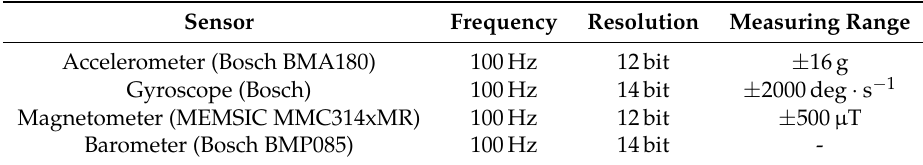
Figure 2. Examples for the instructional screens for the TUG and 5SST. Since the prototype was only evaluated and implemented with German native speakers, the screens were translated into English for this article. Table 1. The specifications of the sensors included in the